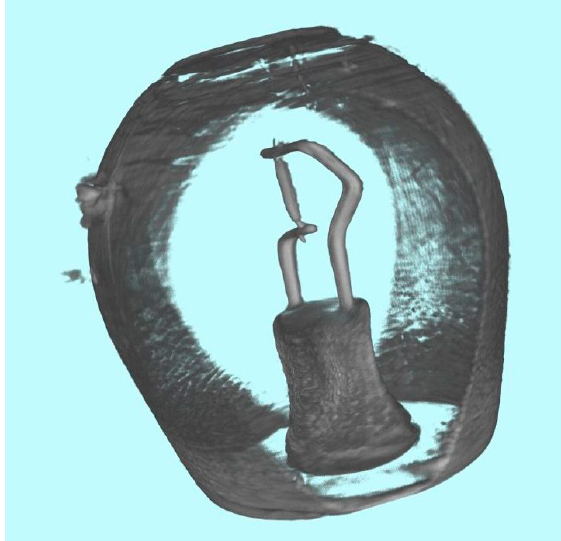
Figure 16. Cut-open 3D view of the optical CT of the light bulb.